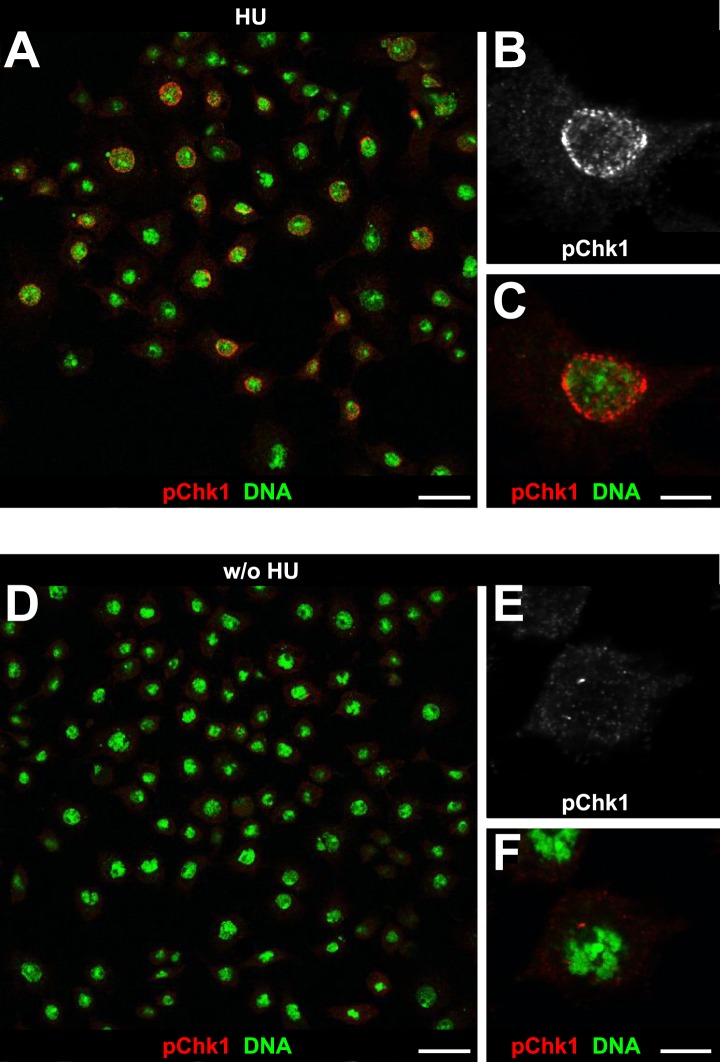
Detection of pGRP by a phosphospecific antibody for Chk1 by immunofluorescence.S2R+ cells were either cultured in the presence of HU (HU) or without HU (w/o HU) and stained with an a phosphospecific antibody for Chk1 (pChk1) and with DAPI (DNA). (A) HU treatment induces a clear signal that is detected in S2R+ cells. HU induces replicative stress by depletion of intracellular dNTP pools. Therefore, only cells that were in S phase during the 12 hr treatment were susceptible to HU. (B and C) Single cell magnifications show that the signal detected by the anti-Chk1 phospho-S345 antibody localizes to the nucleus and resembles the focal staining pattern expected for phosphorylated and active GRP. (D) Untreated cells show only background signal for pChk1. (E and F) Single cell magnifications show that the residual background signal detected in untreated cells is mainly cytoplasmic. Scale bars: 20 µm (A and D), 5 µm (B, C, E, F).